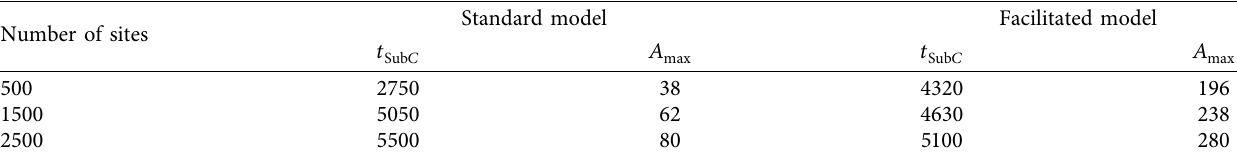
) of cellular automata in the critical state. max